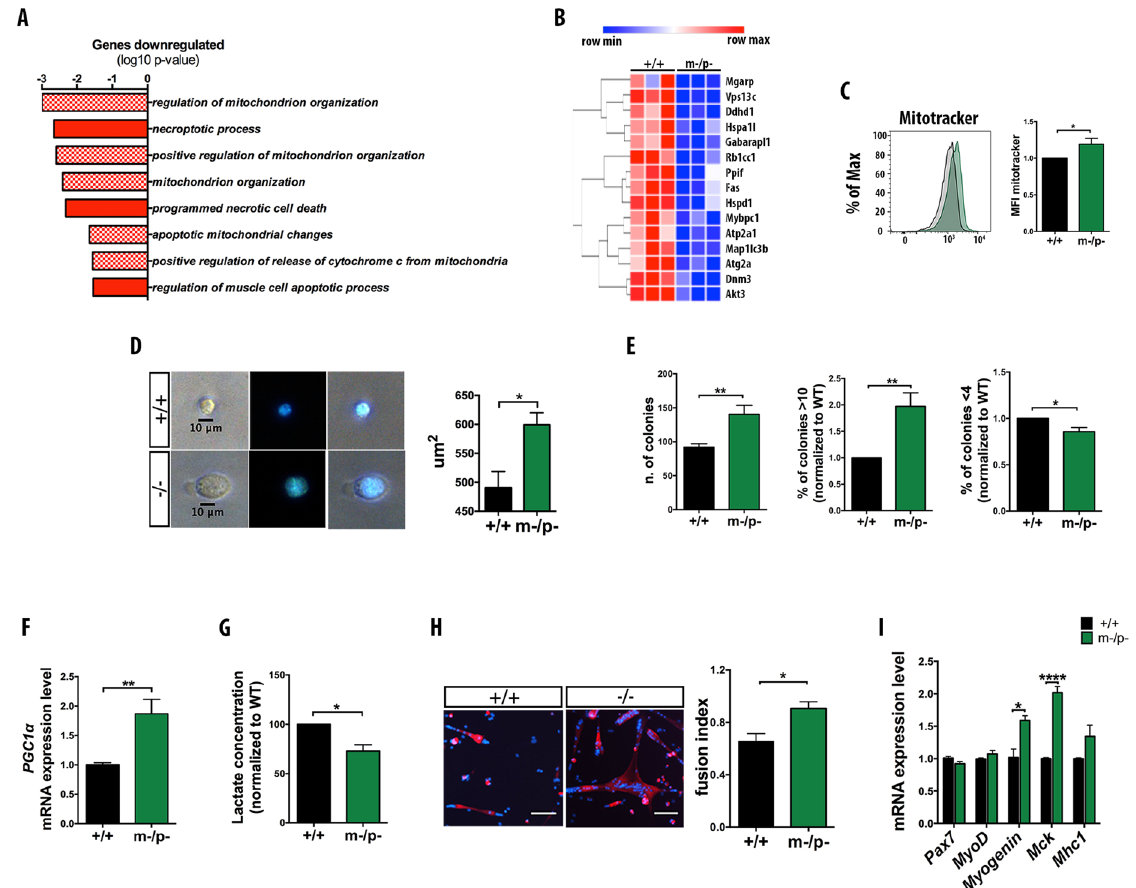
Figure 5. Pw1 deletion results in satellite cell activation. ( A ) Gene Ontology (GO) analysis of downregulated genes in RNA-seq analysis of Pw1 m − /p − satellite cell. GO term represent the biological processes, dashed histograms indicates genes involved in mitochondrial activity and red histograms denote genes implicated in cell death. The x-axis shows the p -value ( − log 10 ). ( B) GO clustering analysis for mitochondrial organization gene categories. Data were obtained from RNA-seq analysis of FACS sorted satellite cells from Pw1 + / + and Pw1 m − /p − mice. The gene tree is shown on the left and gene coloring was based on normalized signals as shown. Each row represents one gene, with red representing high expression and blue representing low expression (n = 3 for each genotype). ( C ) Left panel: Representative FACS analysis of Mitotracker fluorescence in Pw1 + / + (black) and Pw1 m − /p − (green) satellite cells. Right panel: Histogram represent Mitotracker mean fluorescence intensity (MFI) of Pw1 m − /p − satellite cells relative to Pw1 + / + (n = 6 for each genotype). Loss of PW1 corresponds to an increase of mitochondrial activity in satellite cell. ( D ) Left panel: Representative images of FACS isolated Pw1 + / + and Pw1 m − /p − satellite cells grown for 24 h in growth media (GM) and stained with DAPI. Right panel: Histogram showing quantitative evaluation of FACS isolated Pw1 + / + and Pw1 m − /p − satellite cells area (in square micrometers), grown for 24 h in GM (n = 3 for each genotype). Pw1 m − /p − satellite cells are larger than wildtype. ( E ) Histograms showing quantifications of the number of satellite cells per colonies (Left panel), percentages of satellite cell colonies bigger than 10 cells (Middle panel), and percentages of satellite cell colonies smaller than 4 cells (Right panel) from FACS purified satellite cells from adult (3 month) wildtype and Pw1 m − /p − muscles grown for 5 days in GM. Pw1 m − /p − satellite cells display increased proliferative capacity as compared to wildtype (n = 3 for each genotype). ( F ) Expression levels of PGC-1 α from real time PCR normalized to Tbp gene expression from FACS isolated Pw1 + / + and Pw1 m − /p − satellite cells satellite cells grown for 5 days in GM (n = 3 for each genotype). Pw1 m − /p − satellite cells display increased expression level of PGC-1 α gene as compared to wildtype. ( G ) Lactate production from FACS isolated Pw1 + / + and Pw1 m − /p − satellite cells grown for 5 days in GM (n = 4 for each genotype). Pw1 m − /p − satellite cells display decrease secretion of lactate as compared to wildtype. ( H ) Left panel: Representative images of FACS isolated Pw1 + / + and Pw1 m − /p − satellite cells immunostained for MHC (red) and counterstained with DAPI (blue). Satellite cells were grown for 48 h in differentiation media (DM). Scale bar = 200 µ m. Right panel: Fusion index (mean percentage of nuclei incorporated into MHC + cells) of differentiating wildtype and Pw1 m − /p − satellite cells stained as shown in left panel. Pw1 m − /p − differentiated satellite cells show increased Myogenic differentiation (n = 4 for each genotype). ( I ) Expression levels of Pw1 , Pax7 , MyoD , Myogenin , Mck and Mhc1 from real time PCR normalized to Tbp gene expression in differentiated FACS isolated Pw1 + / + and Pw1 m − /p − satellite cells. Differentiating Pw1 m − /p − satellite cells display increased expression level of Myogenin and Mck gene as compared to wildtype (n = 3 for each genotype). Value are expressed as mean ± s.e.m. In all the graphs statistical analyses were performed using Student’s t-test * P < 0.05, ** P < 0.01 and *** P < 0.001. In all the graphs Pw1 + / + ( + / + ) and Pw1 m − /p − (m − /p −